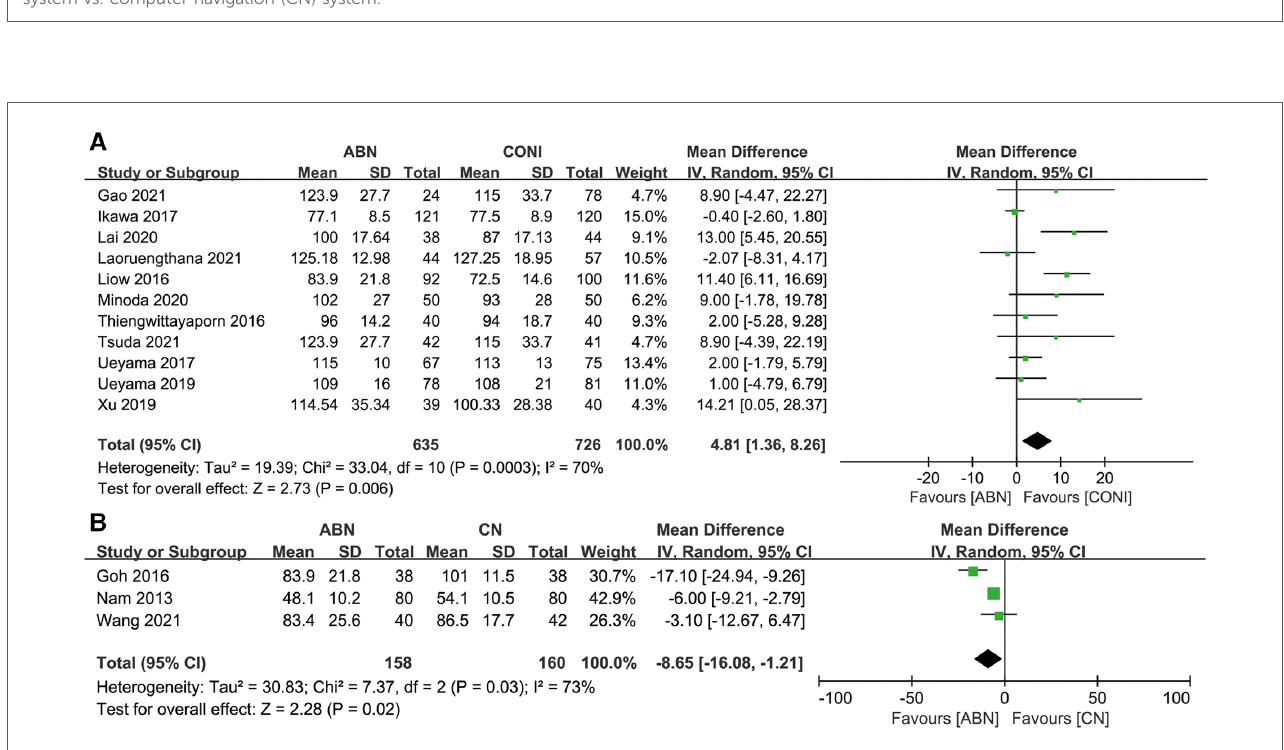
FIGURE 11 Forest plot of postoperative clinical outcomes (PCO). ( A ) Accelerometer-based navigation (ABN) system vs. conventional instrumentation (CONI); ( B ) ABN system vs. computer navigation (CN) system.